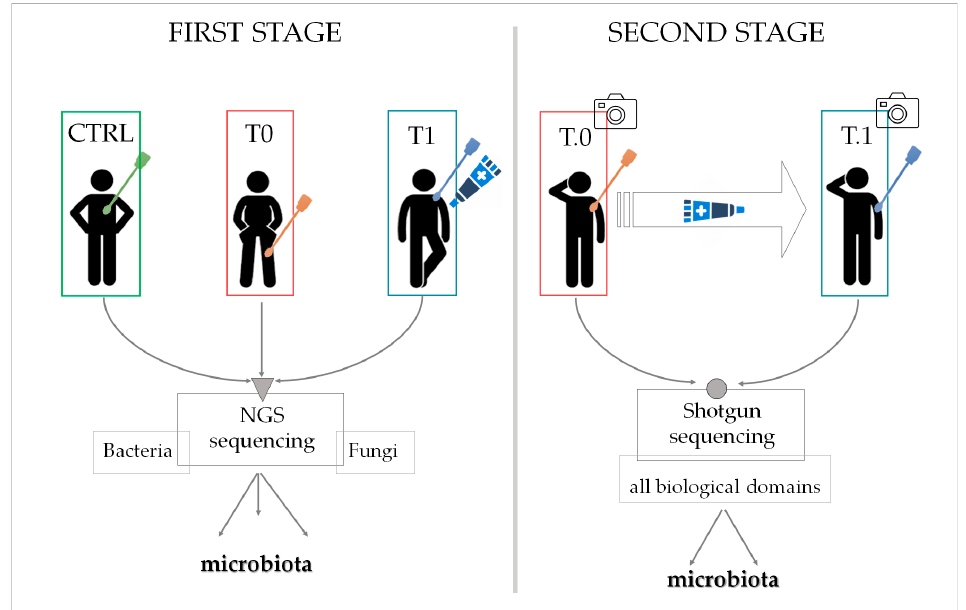
Figure 13. Study set-up and work fl ow. The di ff erent skin conditions and treatments are highlighted by colors: green for patients with healthy skin (CTRL), orange for IP patients, and light blue for IP patients treated with LimpiAL 2.5%. The same colors are used for related swabs. The application of LimpiAL 2.5% is graphically represented by the medical device blue tube. The camera icon indicates that photos of sampled areas have been collected. The identical patient’s icon is used when the same patients are considered in di ff erent groups.